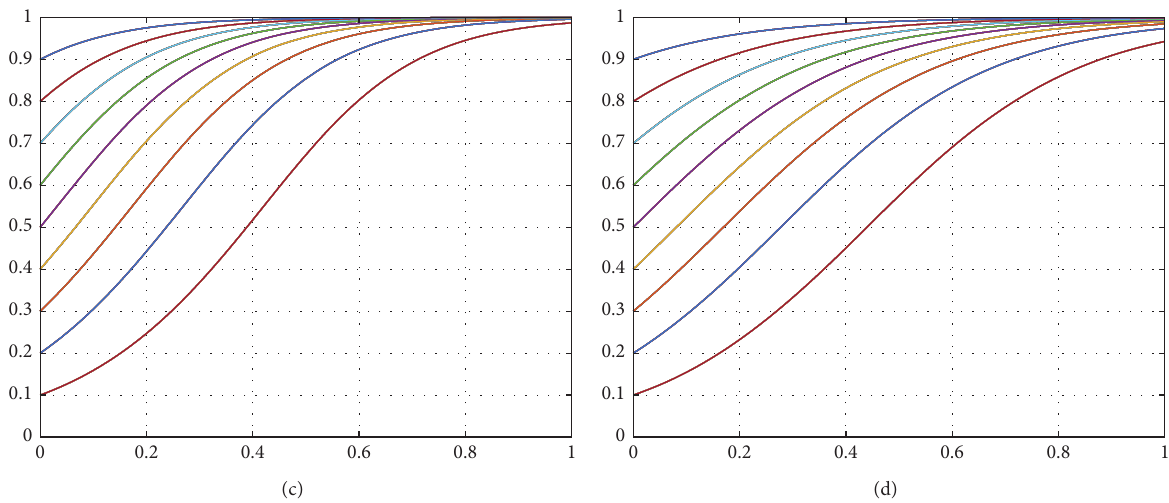
Figure 5: In the case of different λ values, dynamic evolution process of information sharing: (a) λ � λ � 0 . 075; (d) λ (c) λ 1 2